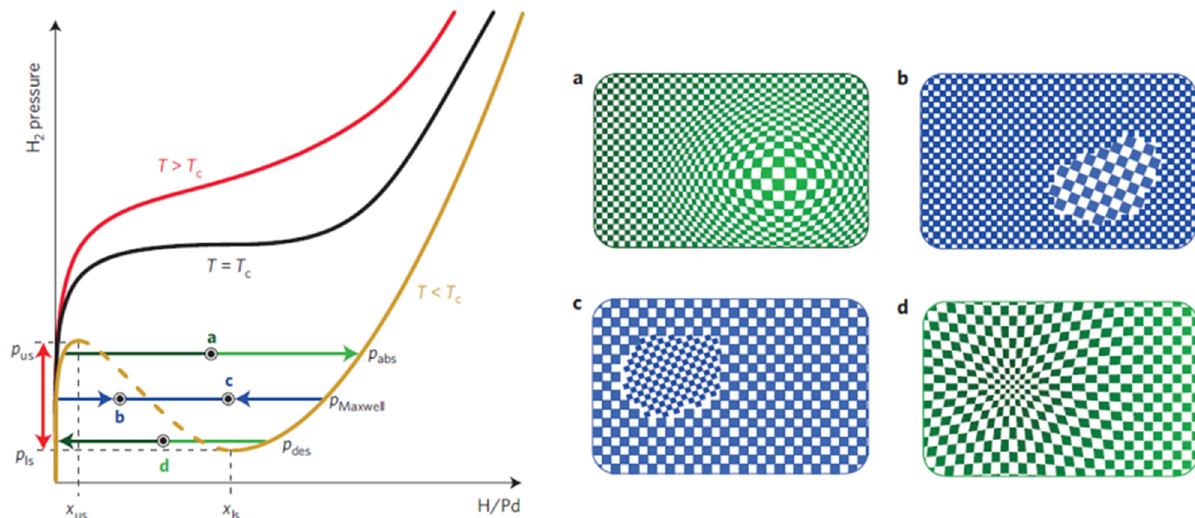
Figure 5. Schematic pressure-composition isotherms at temperatures above, equal and below the critical temperature Tc. The upper spinodal pressure P us and the lower spinodal pressure P ls , together with the corresponding concentration X us and X ls , are indicated for the gold isotherm with T > T C . The full-spinodal hysteresis is indicated with the red arrow. The blue line corresponds to the incoherent pressure changes obtained using the Maxwell construction [55]. In bulk Pd H absorption occurs at P abs ≈ P Maxwell and an expanded β -PdH x phase nucleates incoherently in the dilute α -PdH x phase ( b ), whereas during desorption at P des ≈ P Maxwell the dilute α -PdH x nucleates and grows in the β -PdH x phase ( c ). In the case where coherent absorption occurs at P abs ≈ P us . ( a ) there is no coexistence of the α - and β -PdH x phases [56,57]. The gradient in H concentrations leads to continuous spatial variations of the lattice spacing. The same occurs during coherent desorption at P des ≈ P ls . ( d ). According to Schwarz and Khachaturyan [56,57], the hysteresis is comparable to full-spinodal hysteresis. The black line corresponds to the critical isotherm at T = T c and the red line to a supercritical isotherm at T > T c . [50]. Copyright (2016), with permission from Nature Publisher